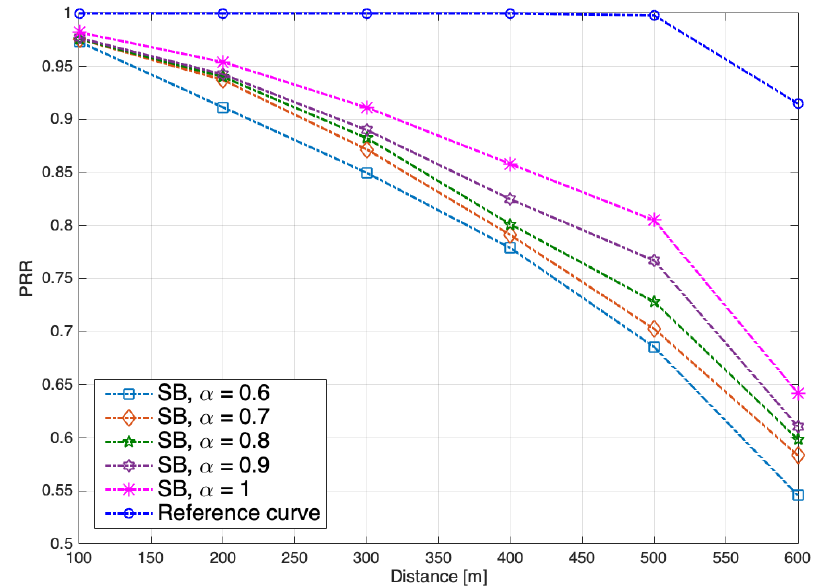
Figure 7. The Packet Reception Ratio (PRR) of vehicles CAM messages broadcast for different vehicle density factors for the single band (SB) frequency